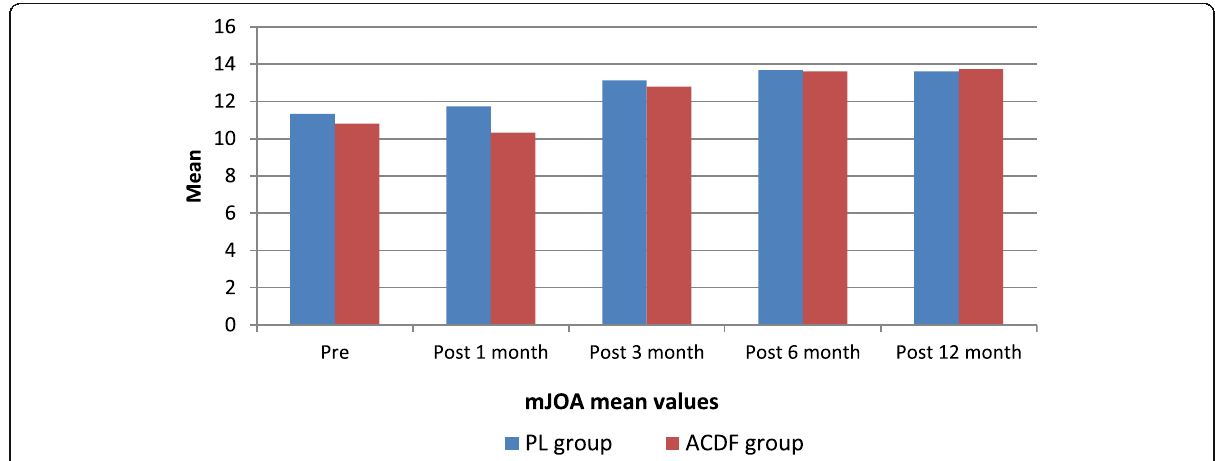
Fig. 1 mJOA score mean value preoperatively and at 1, 3, 6, and 12 months postoperatively for both PL and ACDF